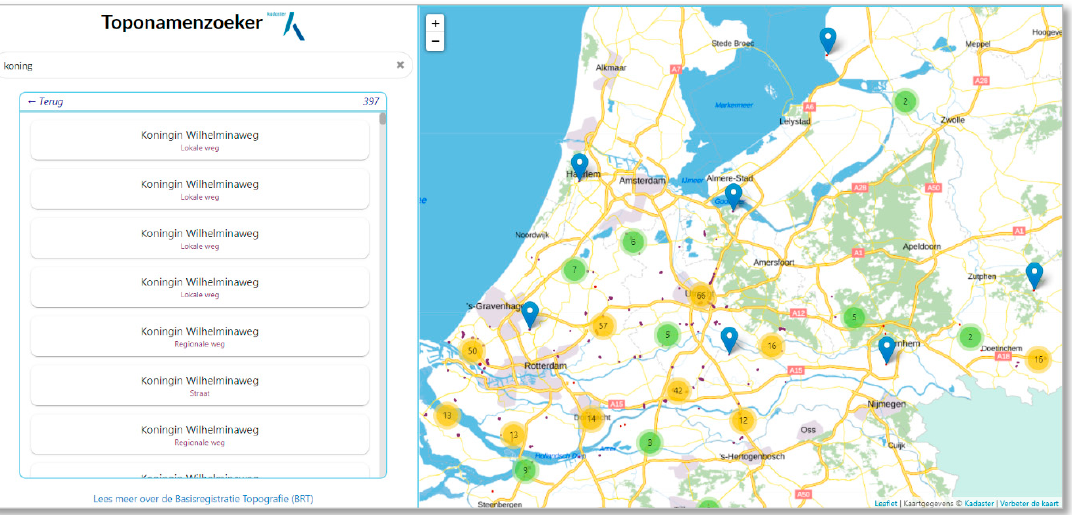
Figure 1. Toponamenzoeker Linked Data Browser, using the search term “Koning”. Retrieved from: https: // labs.kadaster.nl / demonstrators / namen-app / # /